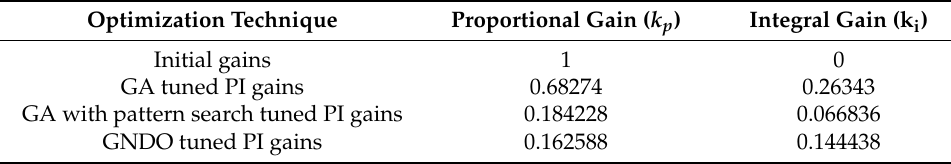
Figure 22. V DC variations with GA, GA with pattern search and GNDO tuned PI controller gains. Table 3. PI gains tuned by GA, GA with pattern search and GNDO algorithm.